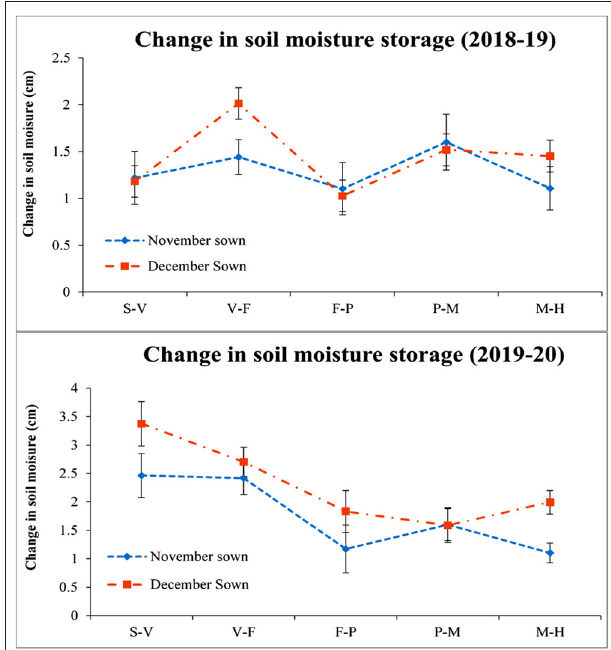
FIGURE 3 | Change in soil moisture storage (0–45cm soil profile) under different dates of sowing (data of 2 years (error bars represent the standard error of mean). S–V, sowing to vegetative; V–F, vegetative to flowering; F–P, flowering to pod development; P–M, pod development to maturity; and M–H, maturity to